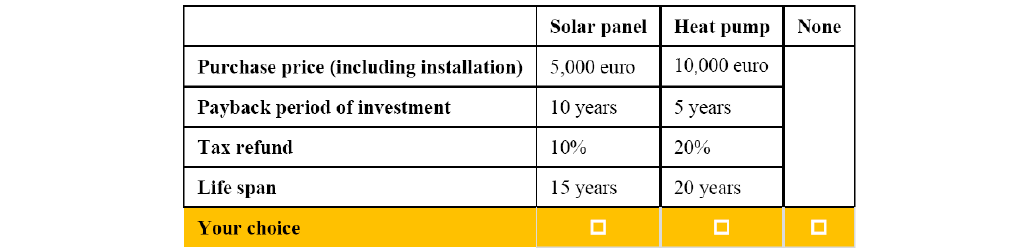
7 of 17 Table 2. Selected attributes and attribute levels of energy equipment. Attributes